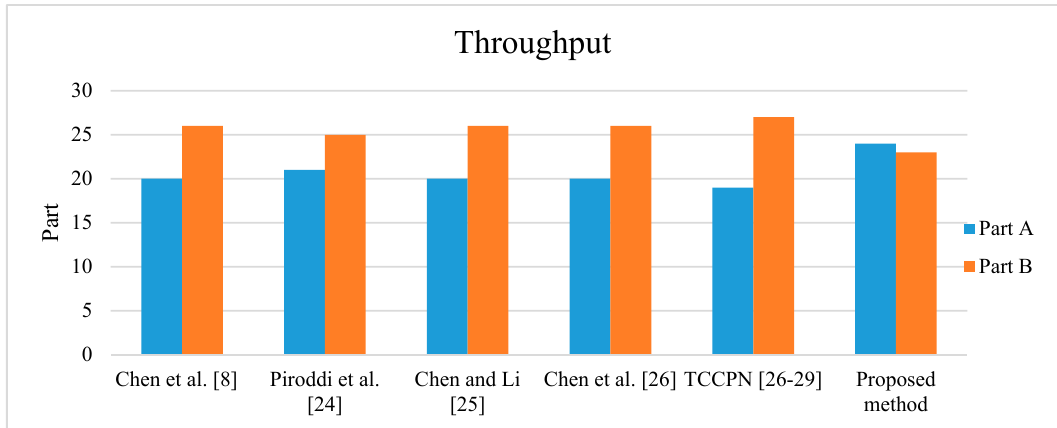
Figure 13. Comparison of throughput for the Petri net model from Figure 11.